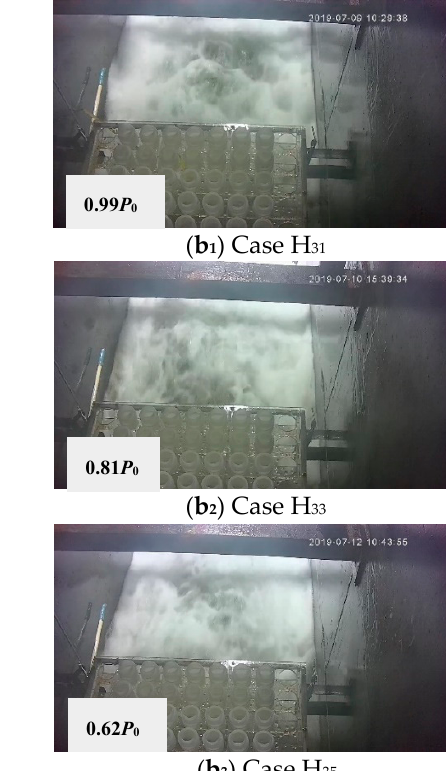
Figure 8. Waterjet aerial diffusion affected by low ambient pressure. ( a ) Q = 115.00 m 3 /h and V = 10.65 m/s; ( b ) Q = 125.00 m 3 /h and V = 11.57 m/s.